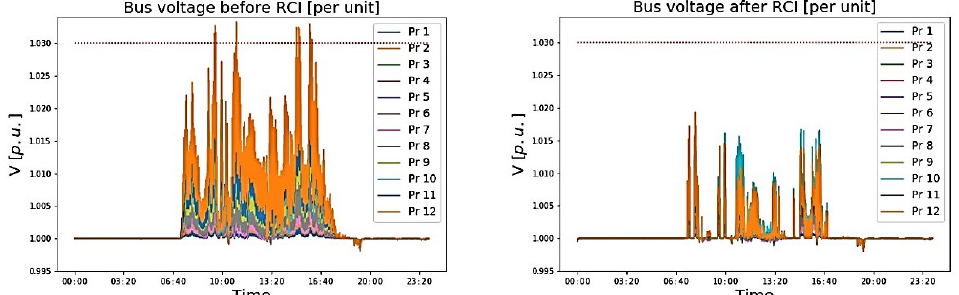
Figure 8. Voltage level evolution in per-unit throughout the entire simulation of one day for all buses. ( Left ): Over-voltage congestion occurs. ( Right ): Congestions are fixed.